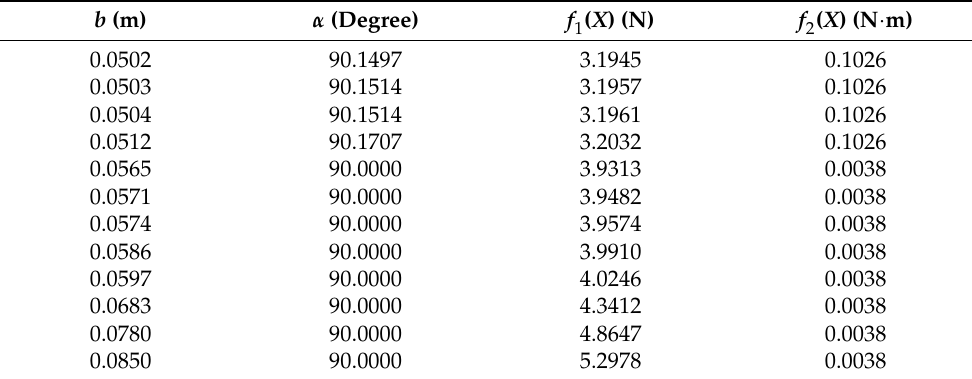
Table 2. Pareto optimal solutions with four objective functions.